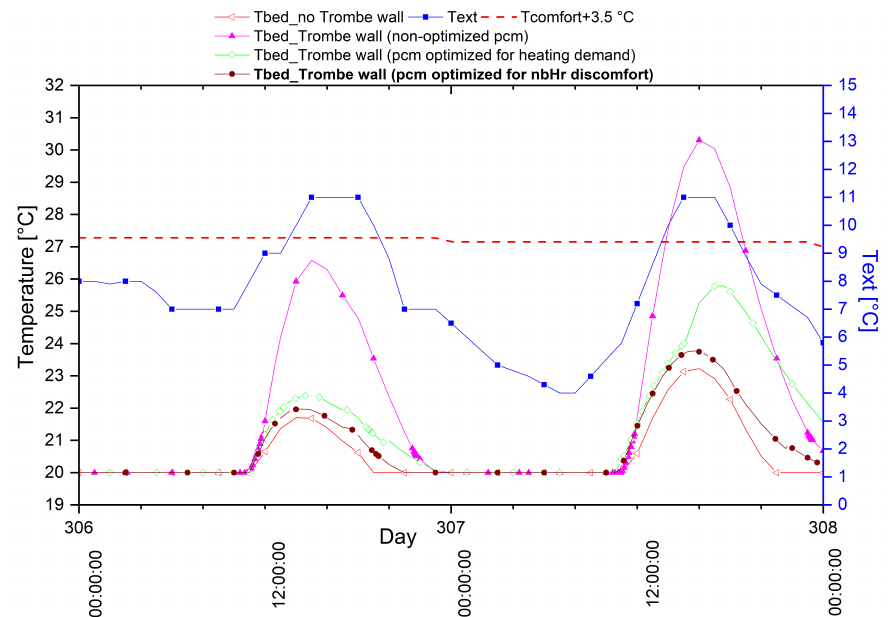
denote respectively the comfort+3.5 ◦ C